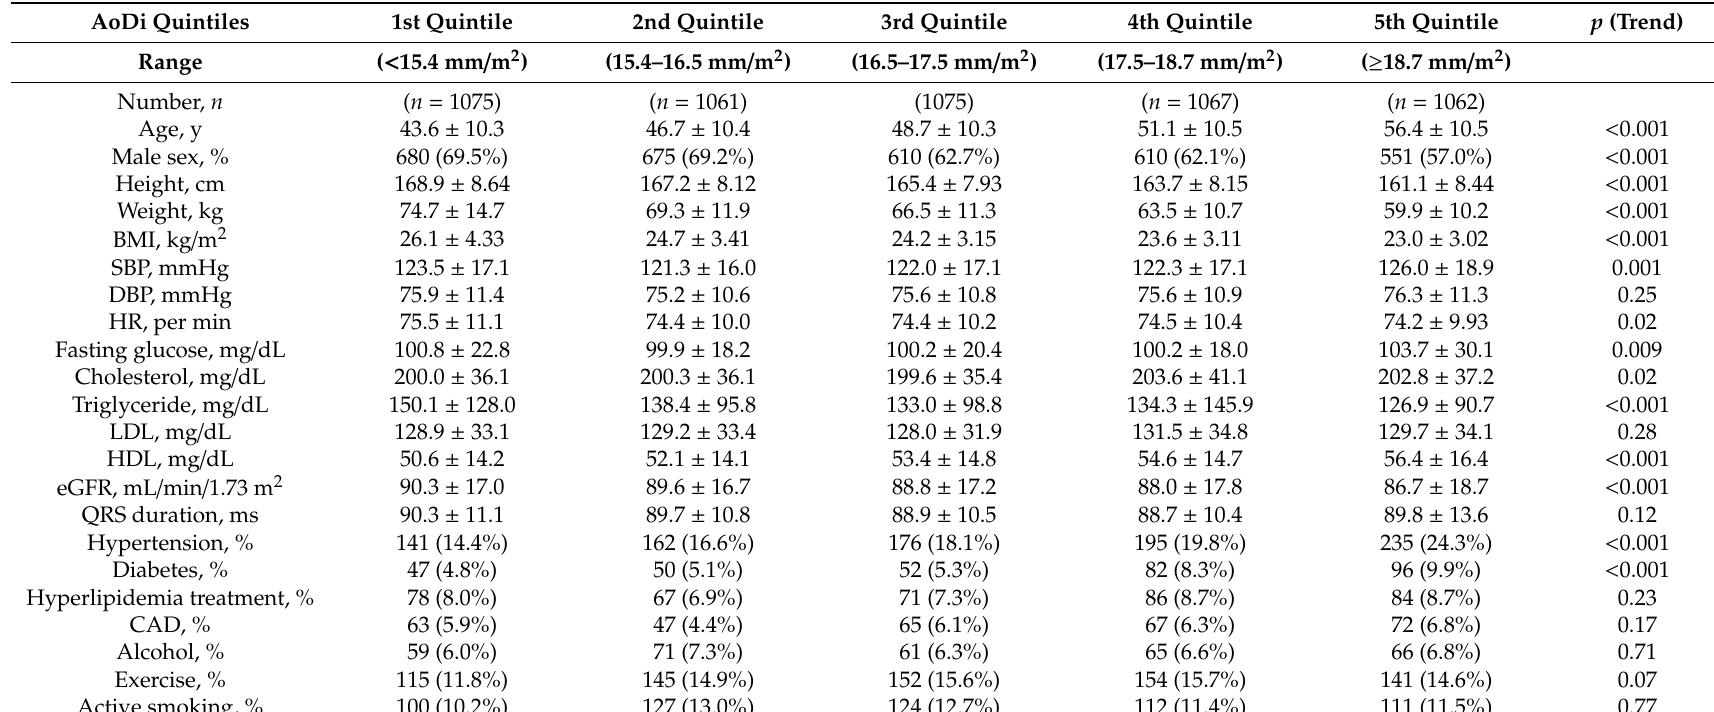
Table 1. Baseline characteristics of the study population stratified by indexed aortic root